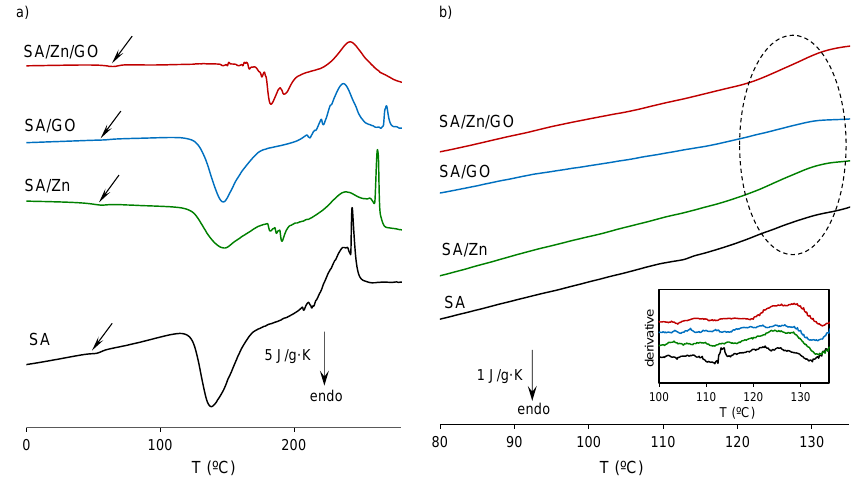
Figure 4. ( a ) Normalized heat flow on heating at 20 °C/min, ( b ) normalized heat flow on cooling at 10 °C/min after dehydration. The inset in ( b ) shows the temperature derivative of the normalized heat flow from 100 to 140 °C.